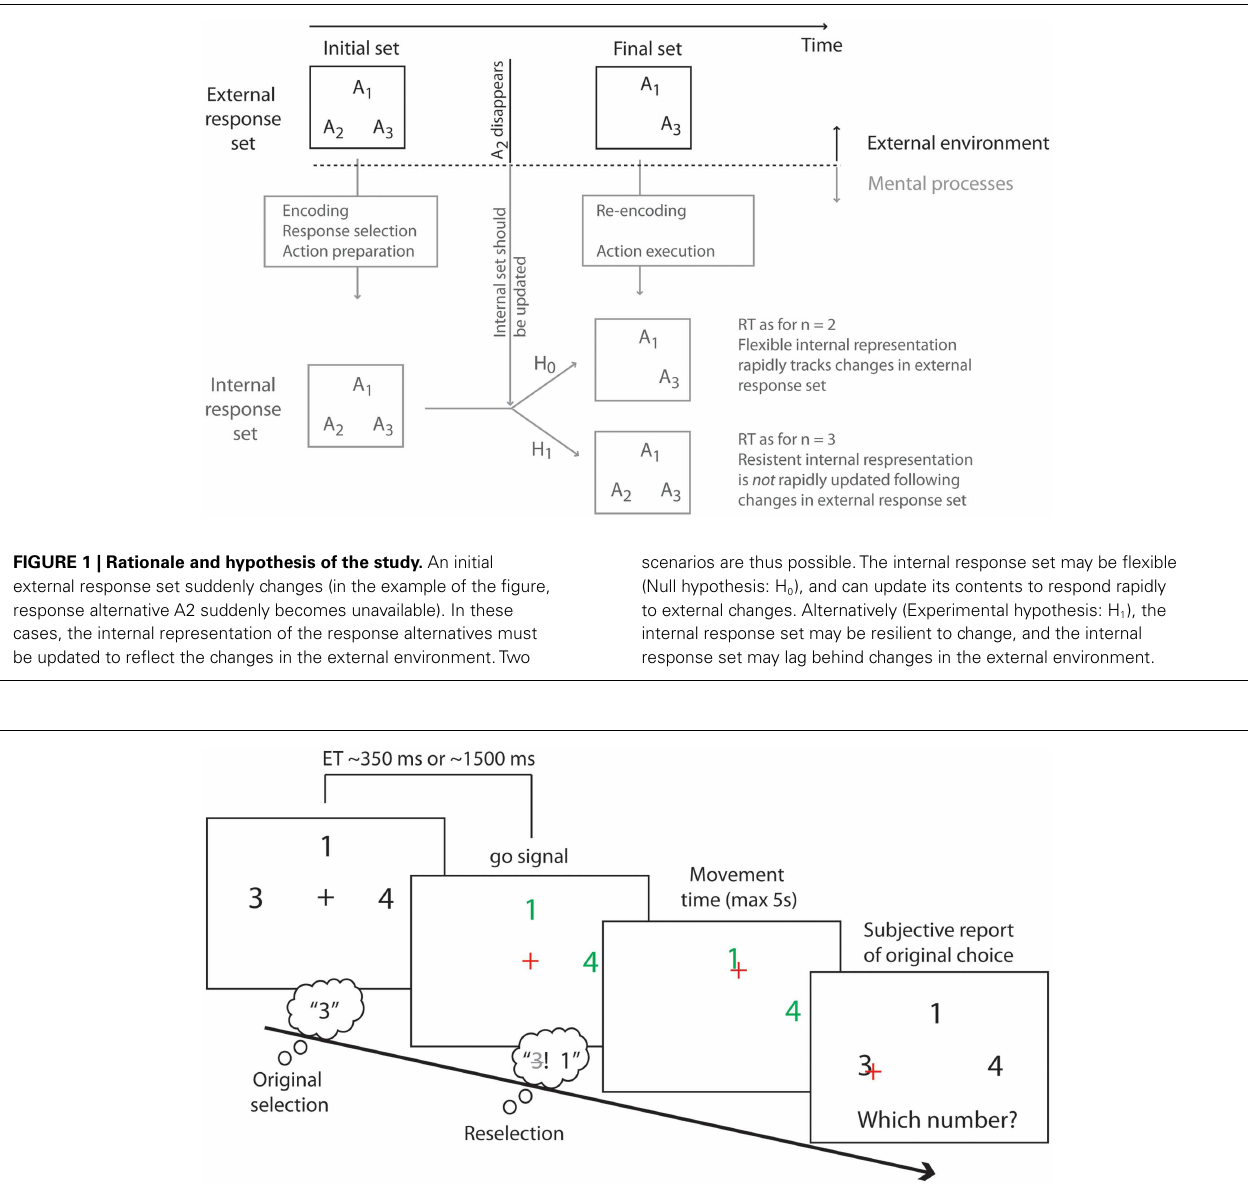
numbers could disappear, leaving a final response set with a size between 1 and the original response set size. Participants could click on their originally chosen number if it remained in the final response set. Instead, they would have to reselect a number other than their first choice if it had disappeared from the final response set. Participants then reported their original number